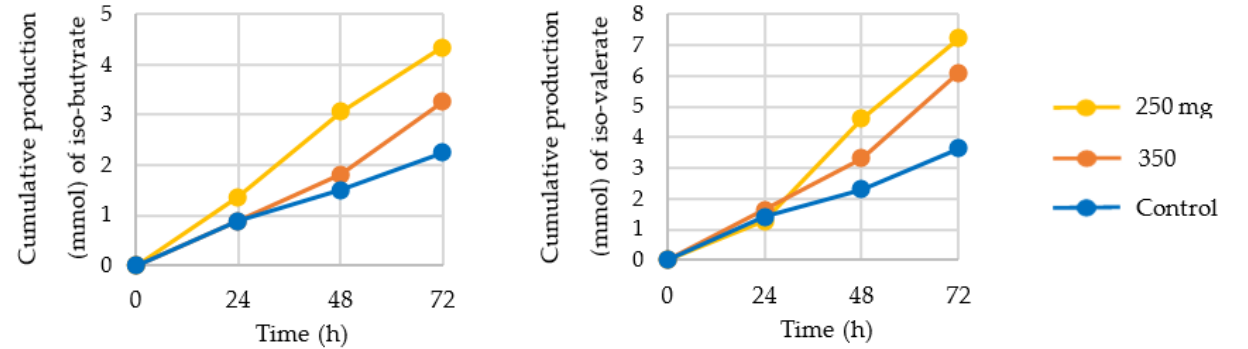
Figure 6. Cumulative production (mmol) of the branched-chain fatty acids (BCFA) iso-butyrate and iso-valerate at 24 h, 48 h, and 72 h after supplementation with 250 mg (yellow) or 350 mg (orange) Citrus Fruit Extract or control (standard ileal efflux medium (SIEM; blue)).